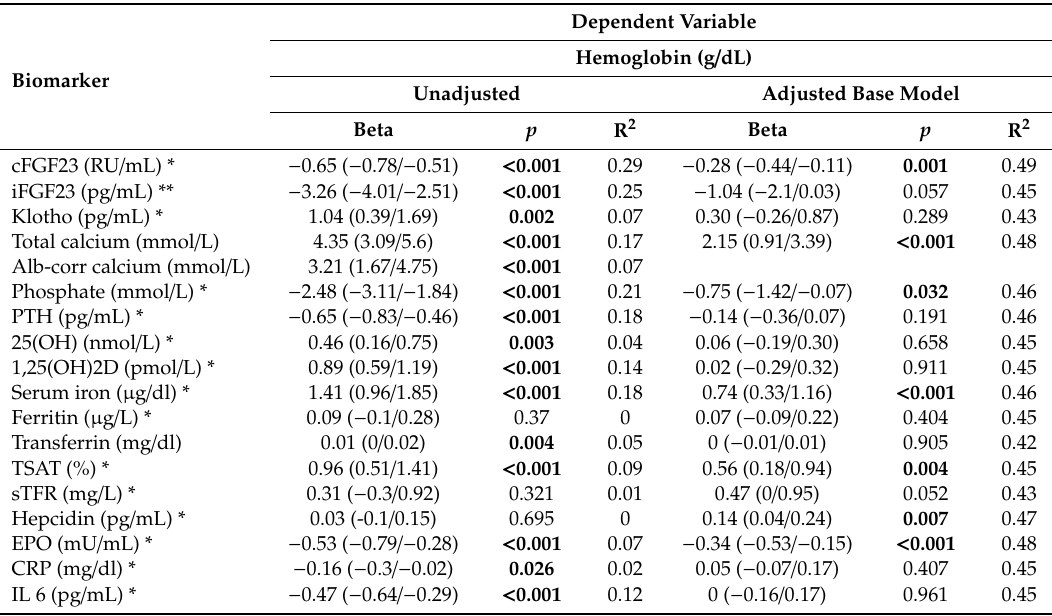
Table 2. Dependence of hemoglobin on biomarkers of mineral metabolism, iron metabolism, EPO concentrations, and inflammation